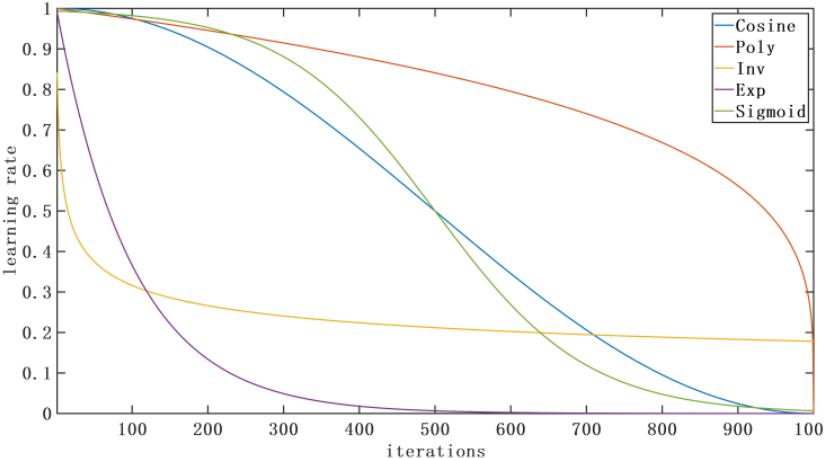
Figure 9. Results of five learning rate attenuation strategies. According to Equations (8 −13 ), the learning rates of T-S fuzzy neural networks are β and φ . Five learning rate attenuation strategies are used for training β and φ, respectively. The initial values of the learning rate are 𝛽